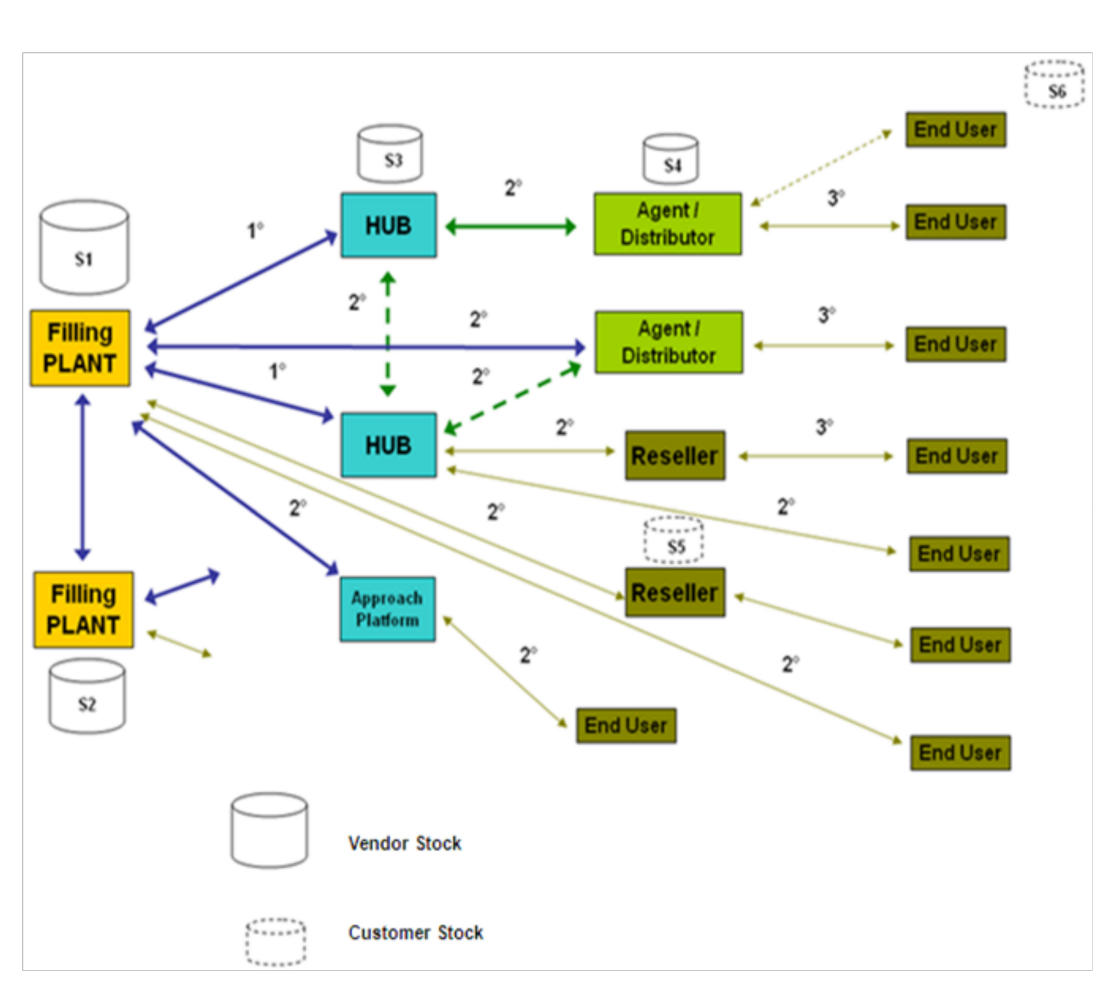
Figure 1. Diagram of the Distribution